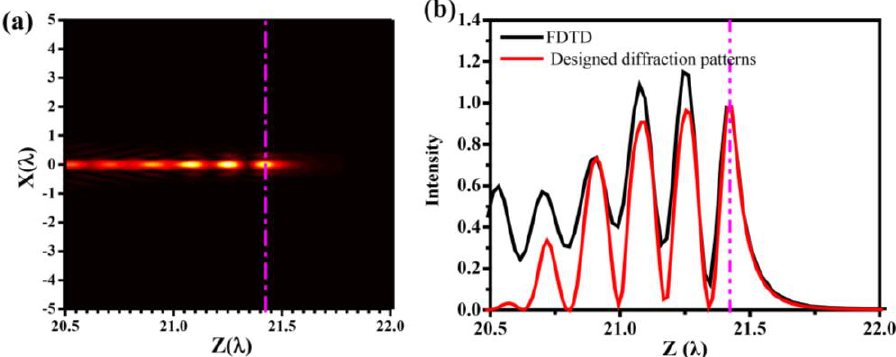
5 of 8 Figure 2. The design results: characterization of solid immersion lens. ( a ) Intensity distribution of the light beam along the propagation direction. ( b ) Intensity distribution near the silicon – air inter- face. ( c ) Intensity (blue line), FWHM (red line) and side lobe (green line) electric field curves in the propagation direction. 3. Simulation Results and Discussion To evaluate the performance of the designed lens, we simulated the device using fi- nite – difference time – domain software (FDTD Solutions, Lumerical, Inc., Vancouver, Can- ada.). Terahertz waves come in from the structure of the rings and out from the silicon column surface. The results of focusing on the XZ plane of the solid immersion lens are shown in Figure 3a. It can be seen that the distribution trend of the focal spot is close to